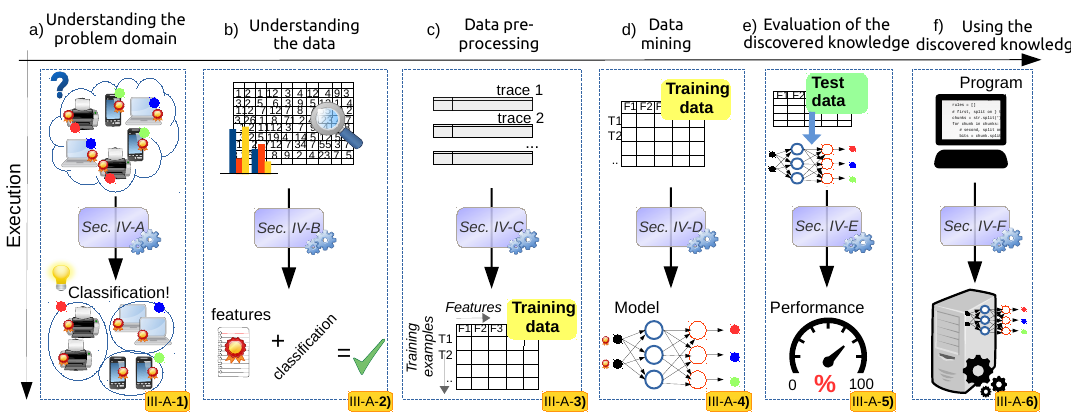
Figure 1. Transformations through each step of the data-driven knowledge discovery process: ( a ) Understanding the problem domain; ( b ) Understanding the data; ( c ) Data pre-processing; ( d ) Data mining; ( e ) Evaluation of the discovered knowledge; ( f ) Using the discovered